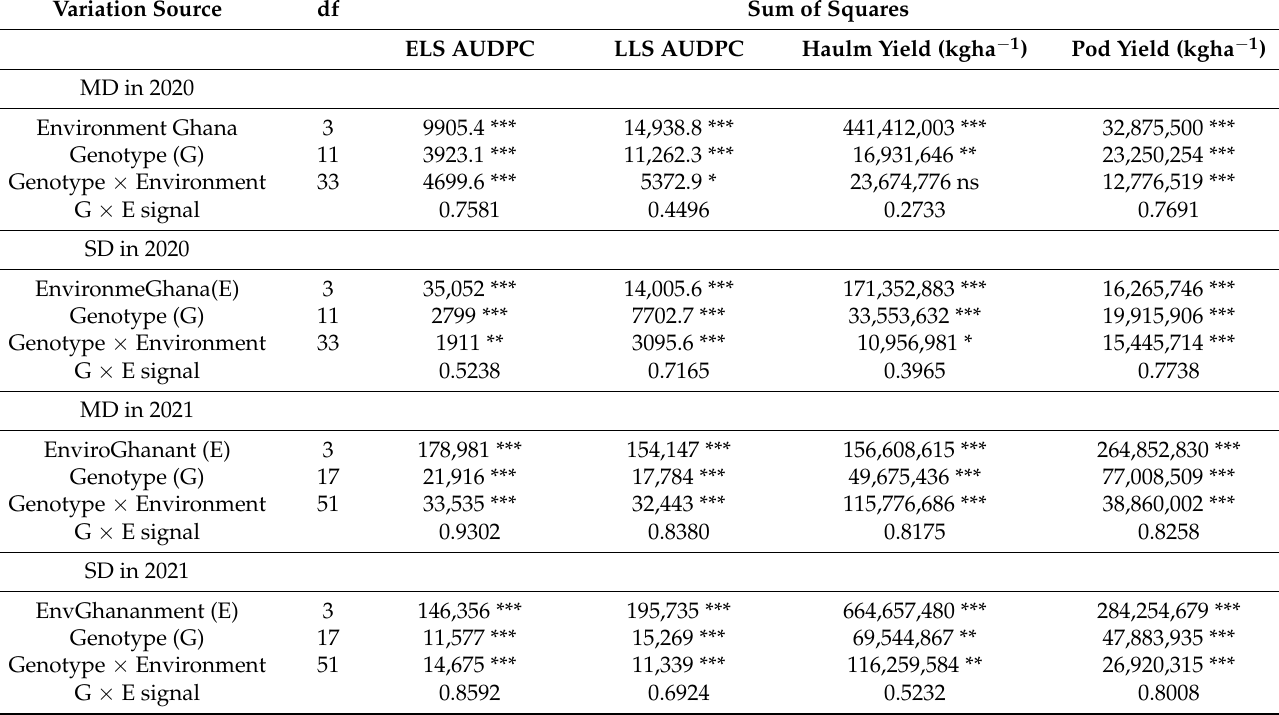
Table 5. AMMI model summary showing contribution of the various sources of